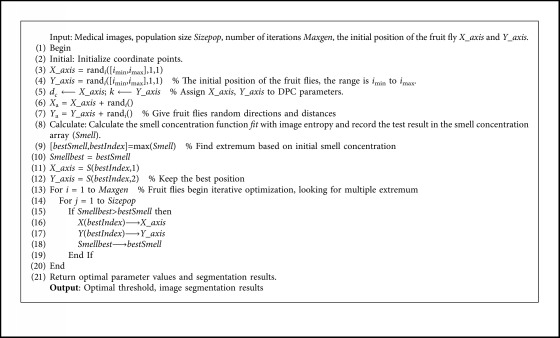

FOA-DPC Algorithm.